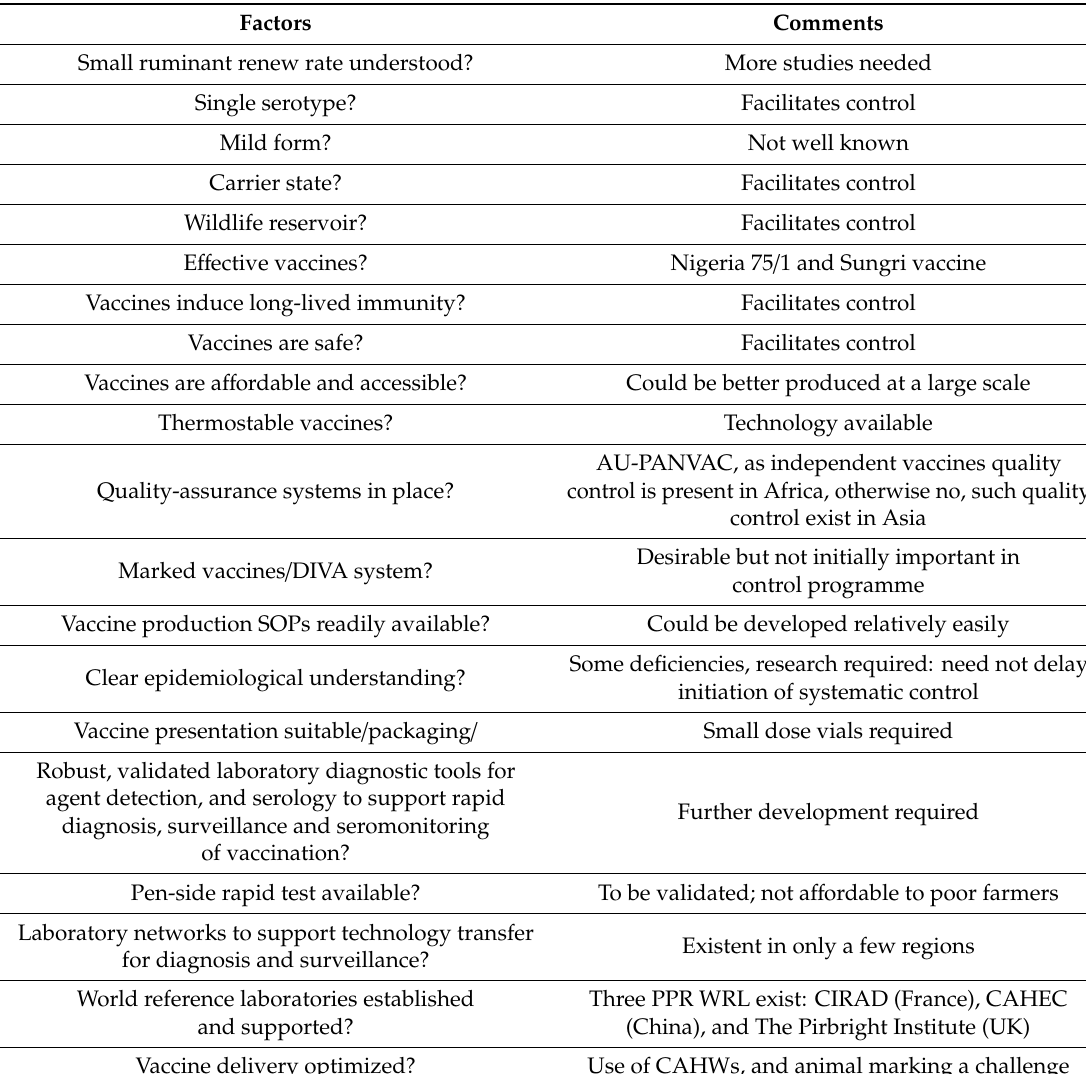
Factors important in mounting systematic control programme for PPR (personal communication—findings from a PPR workshop in 2012, Horn of